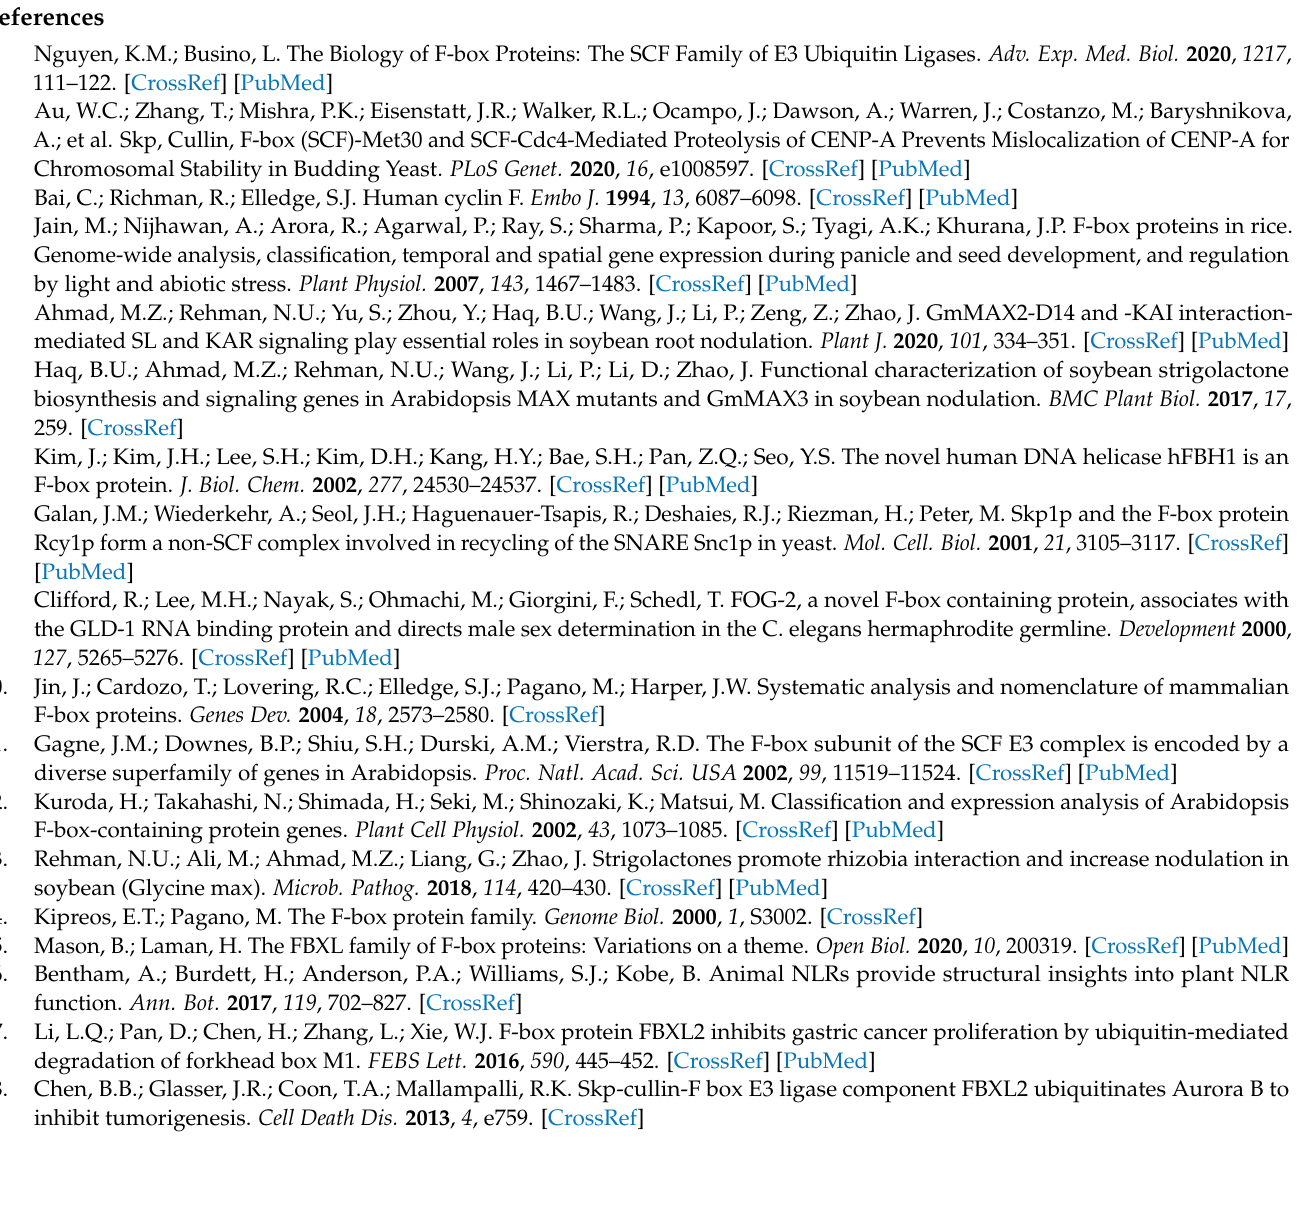
network. Figure S1: The conserved motifs, Exon–intron structures of G. arboretum FBXLs . Figure S2: The conserved motifs, Exon–intron structures of G. raimondii FBXLs . Figure S3: The location of FBXL genes on Ga, Gr, Gh, and